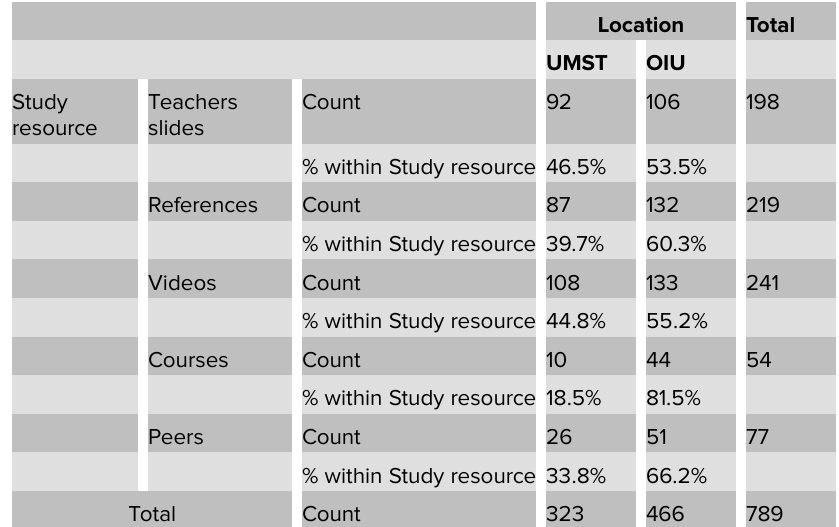
Table 5: Comparison between study methodologies of UMST and OIU